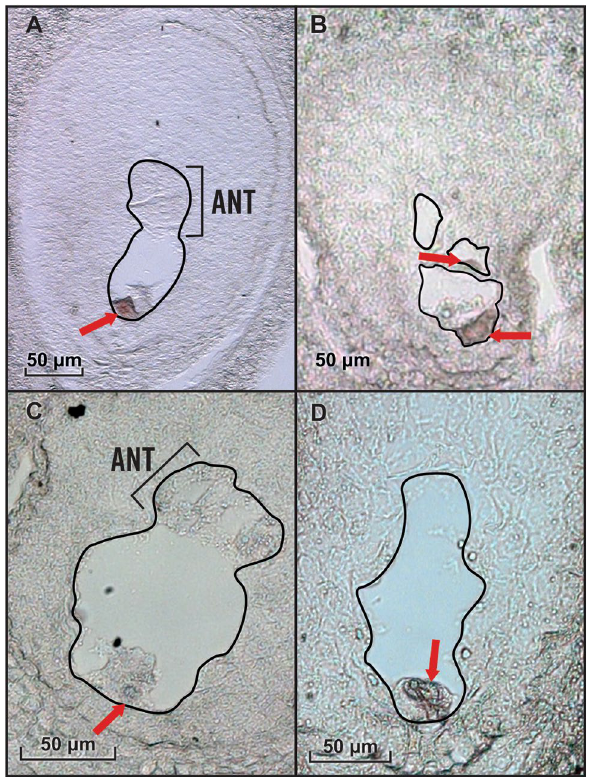
Figure 3. RNA in situ hybridization of sexual (B-2S) and parthenogenetic (B-12–9) ovary sections at day of anthesis. ( A ) A sexual ovary section displaying egg-cell specific signal with an EC1.3 probe. ( B ) A parthenogenetic ovary section with multiple aposporous embryo sacs, displaying two egg-cell signals with an EC1.3 probe. ( C ) A sexual embryo sac displaying observed background/sense signal. ( D ) A parthenogenetic ovary section with a single aposporous embryo sac displaying egg-cell CcASGR-BBML signal. Black outlines define both sexual and aposporous embryo sacs. Sexual embryo sacs are denoted with brackets defining the antipodals (ANT) which do not develop in aposporous embryo sacs. The red arrow denotes the egg cell.